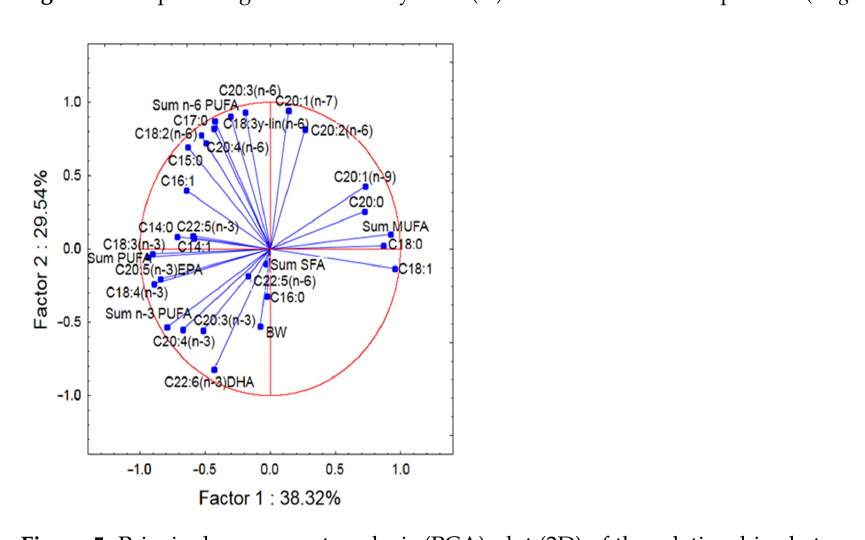
Figure 5. Principal component analysis (PCA) plot (2D) of the relationships between all variables (fatty acid (% of the total fatty acids), total body length (LT), and body weight (BW)) in muscles of the European eel ( Anguilla anguilla L.).